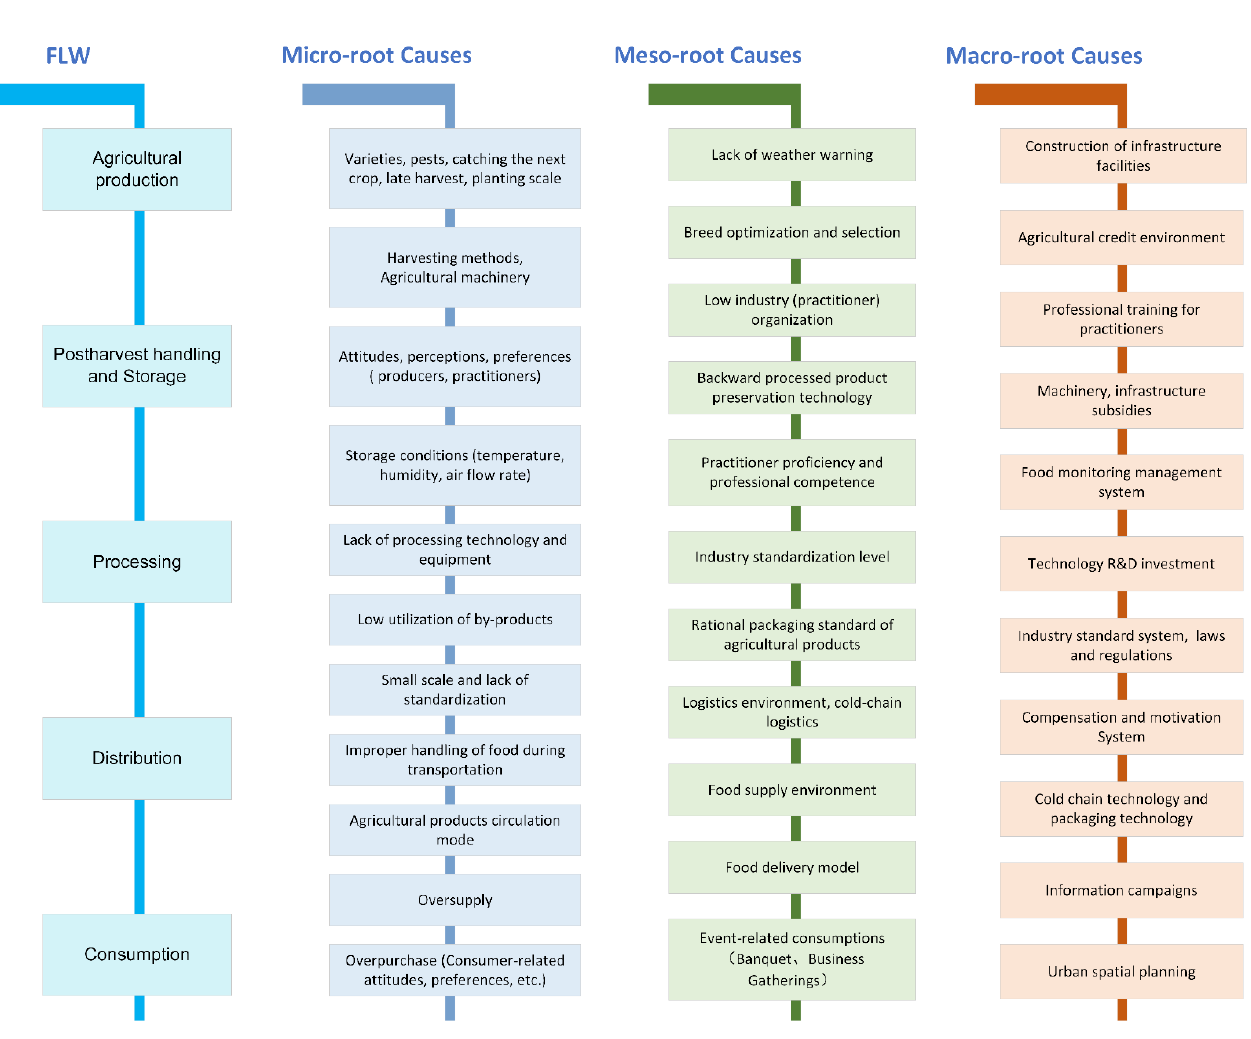
Figure 8. Root causes of FLW in each segment of FSC.